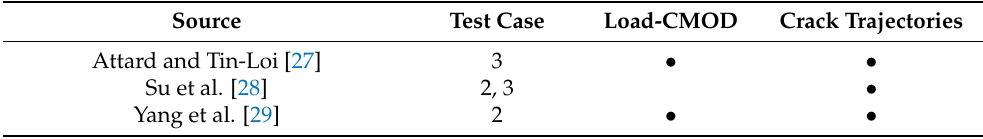
Table 5. Benchmark information considering particle or meshfree